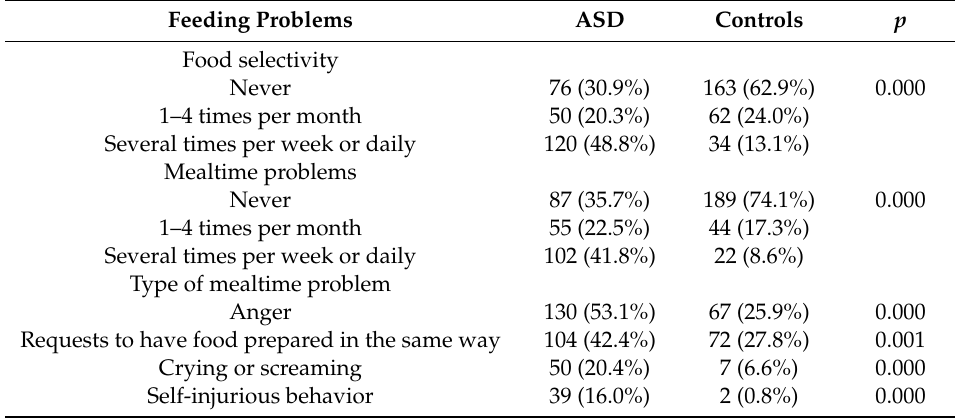
Table 4. Frequency of feeding problems in children and adolescents with autism spectrum disorders (ASD) and controls ( n , % of total